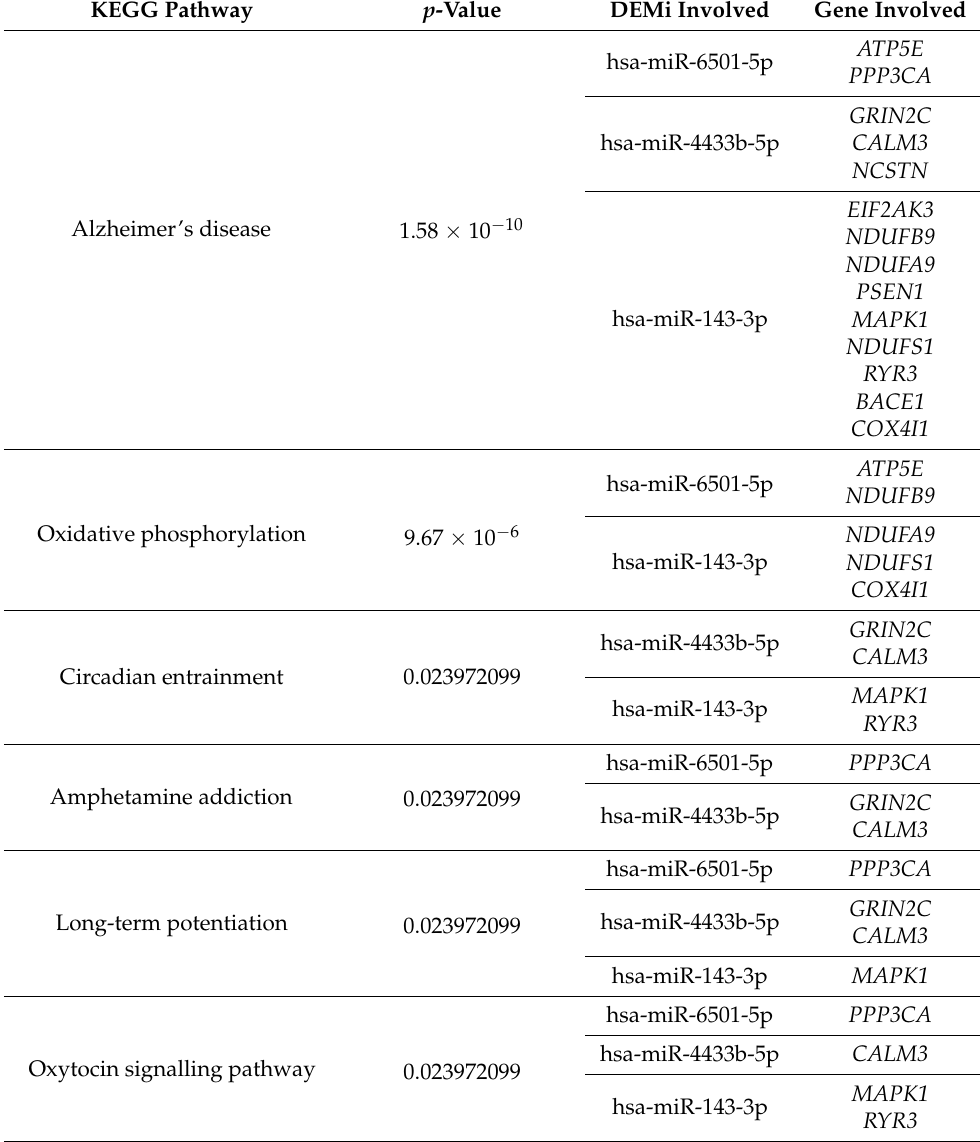
Table 3. KEGG pathways associated with the DEMi signatures and the respective target genes. KEGG Pathway p -Value DEMi Involved Gene Involved